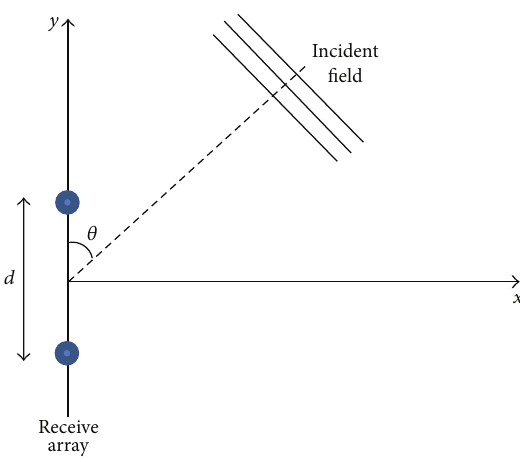
Figure 2: SIMO system with two identical center-fed dipoles arranged side by side on the horizontal plane ( 𝑥𝑦 ) at the receiver side. The dipoles are aligned in the direction of the 𝑧 -axis and are copolarized with the incident electric field which is also linearly